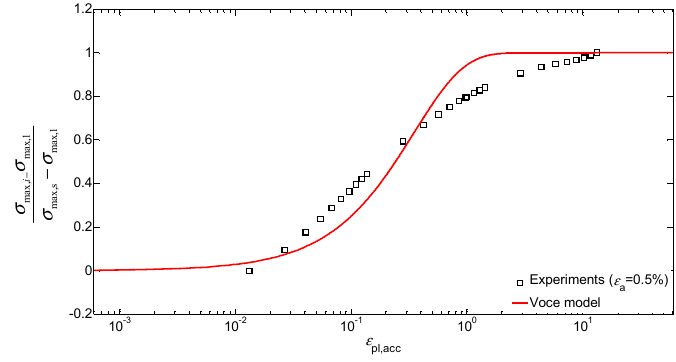
Figure 3. Experimental data for ε a = 0.5% (markers) fitted by the isotropic model.